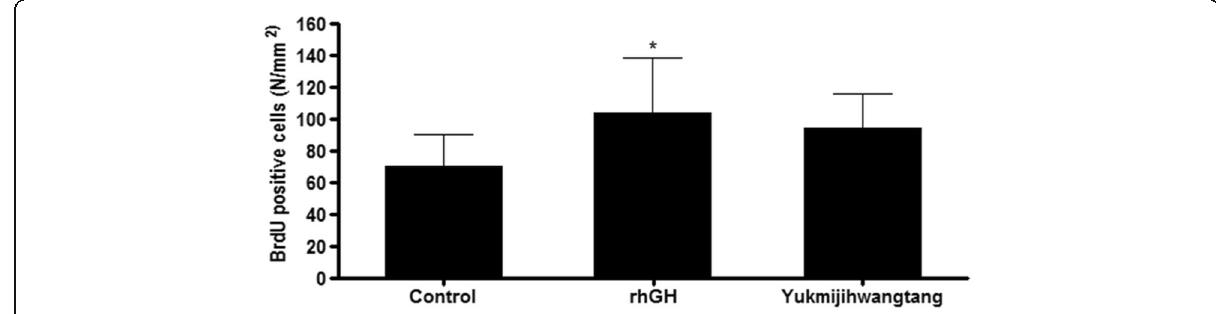
Fig. 5 Effects of YJT on chondrocyte proliferation in the growth plates of adolescent female rats. BrdU-positive cells were quantified. The control group received distilled water, the rhGH group received 20 μ g/kg rhGH and the YJT group received 300 mg/kg YJT. Values are means ± SD of eight rats. * P < 0.05 compared with the control